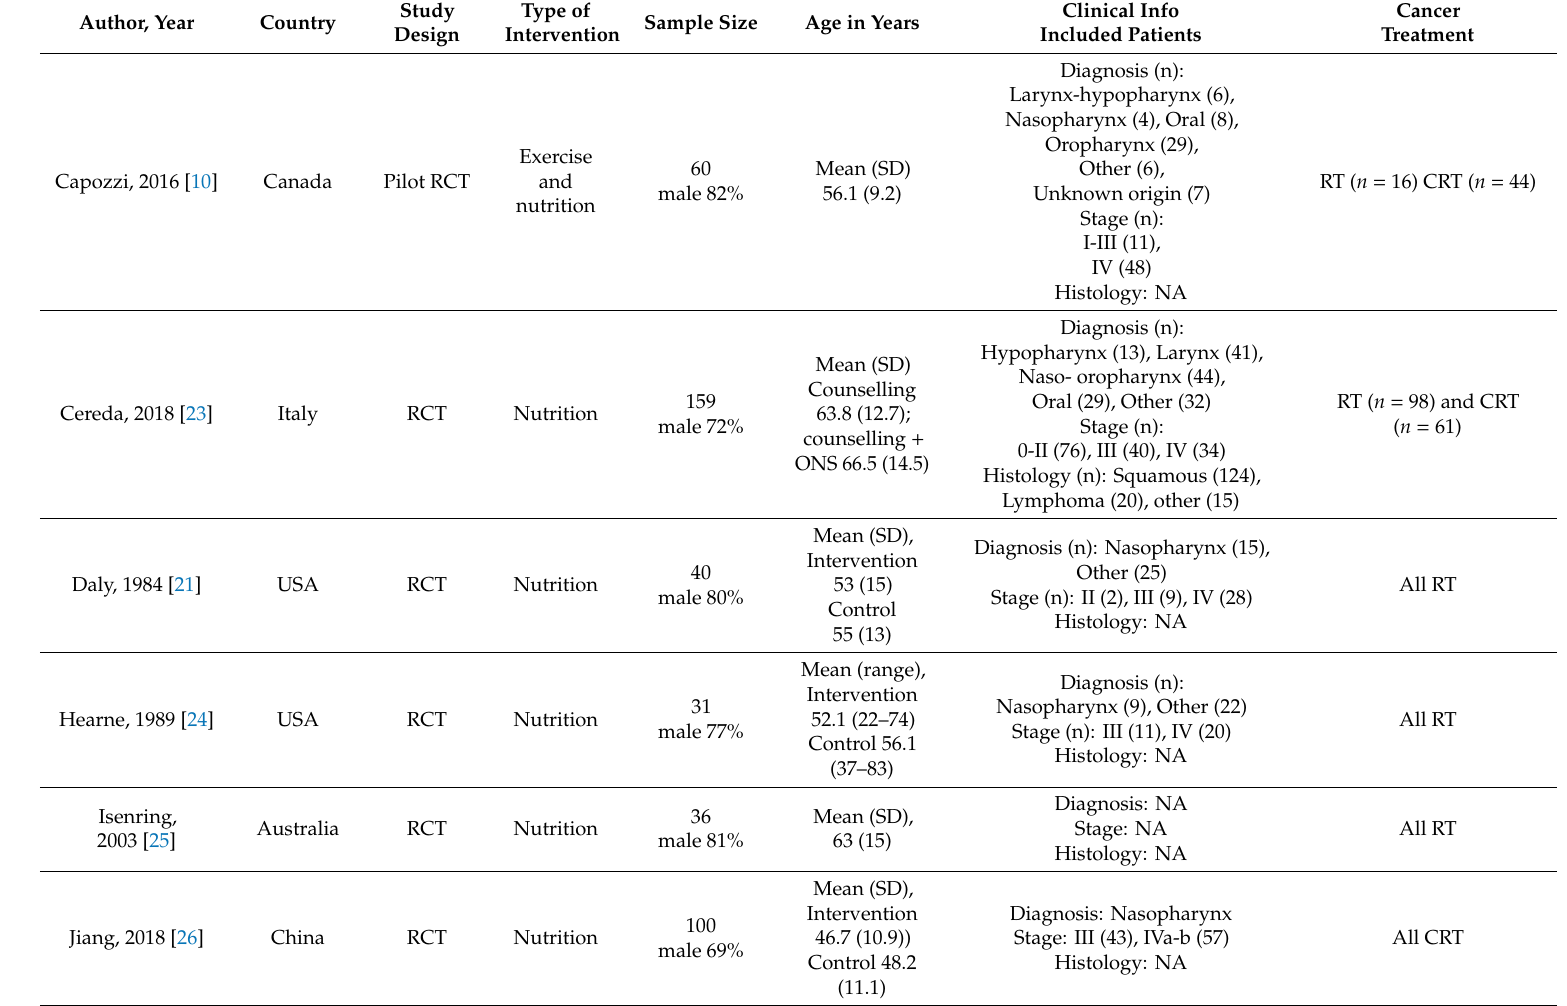
Table 2. Characteristics of the included studies organized